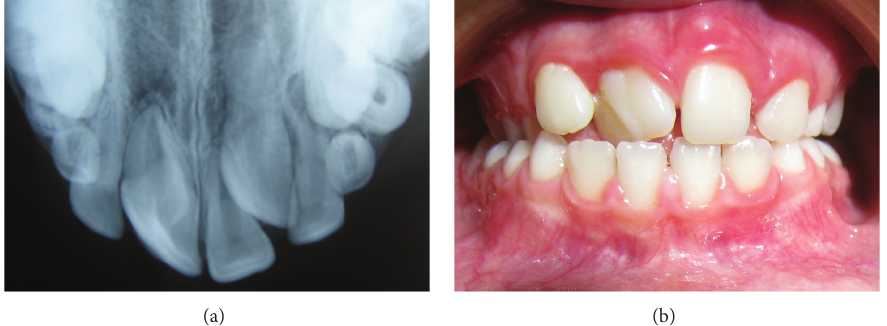
Figure 1: (a) Occlusal radiograph of the patient, demonstrating the large incisor and the unerupted supernumerary incisor. (b) Close-up view of the tooth, showing abnormal crown dimensions and morphology.